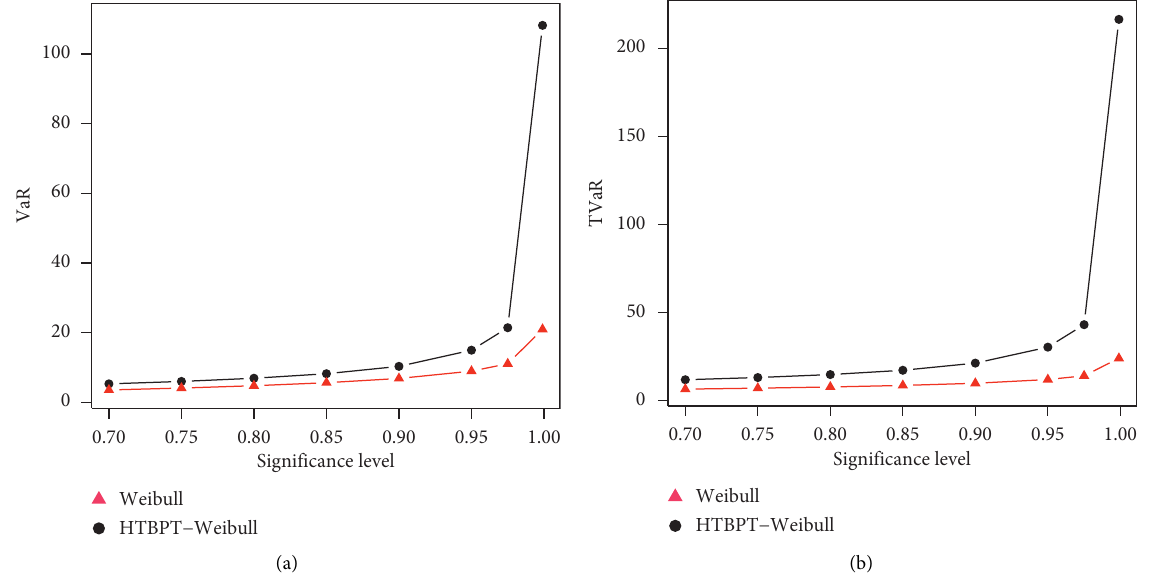
Figure 12: Graphical sketching of the numerical results provided in Table 5. Table 6: The MLEs of the competing models for the vehicle insurance loss